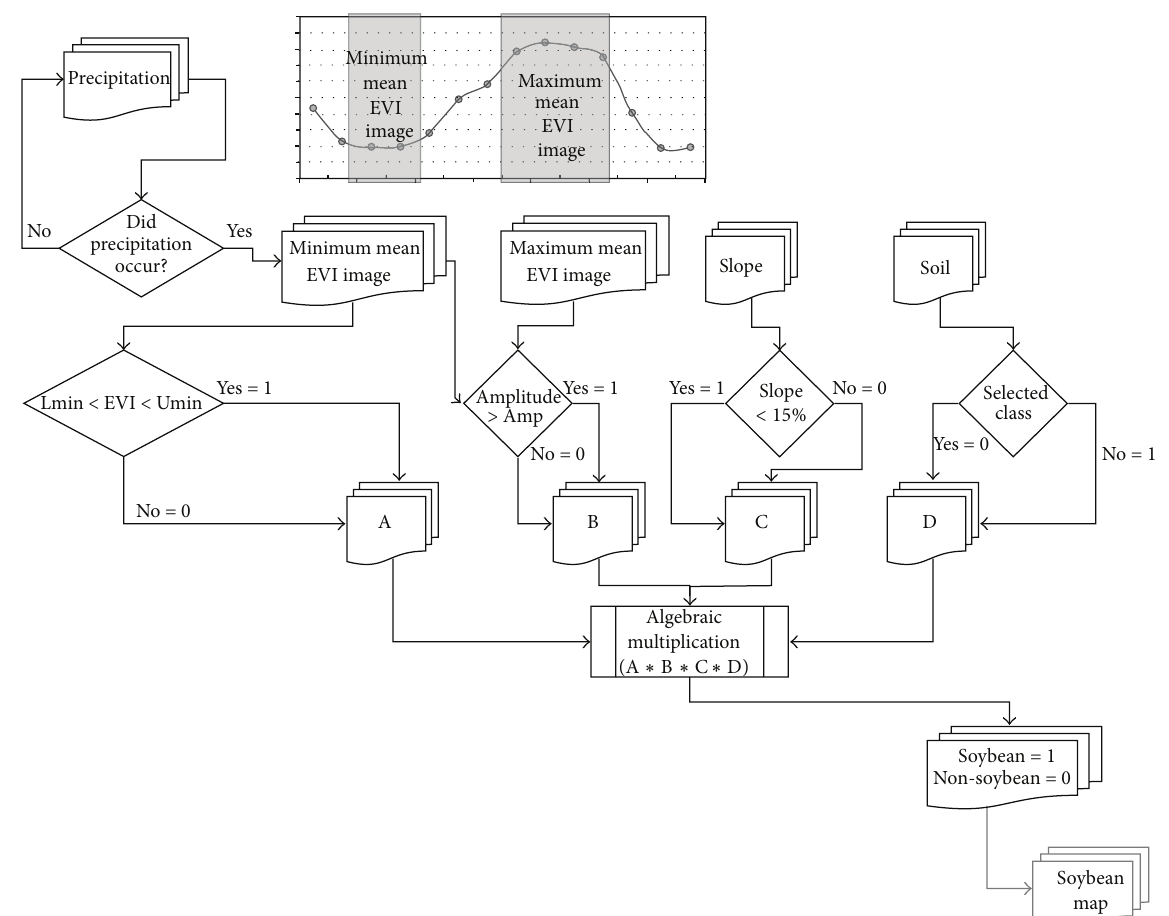
Figure 2: Flowchart of the MCDA classification [1] based on MODIS/EVI images.